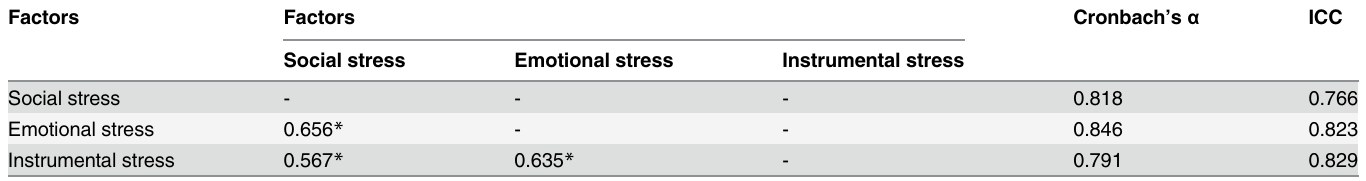
Table 3. The interclass correlations, internal reliability and test-rest reliability of 17-item CSS-HIV factors.